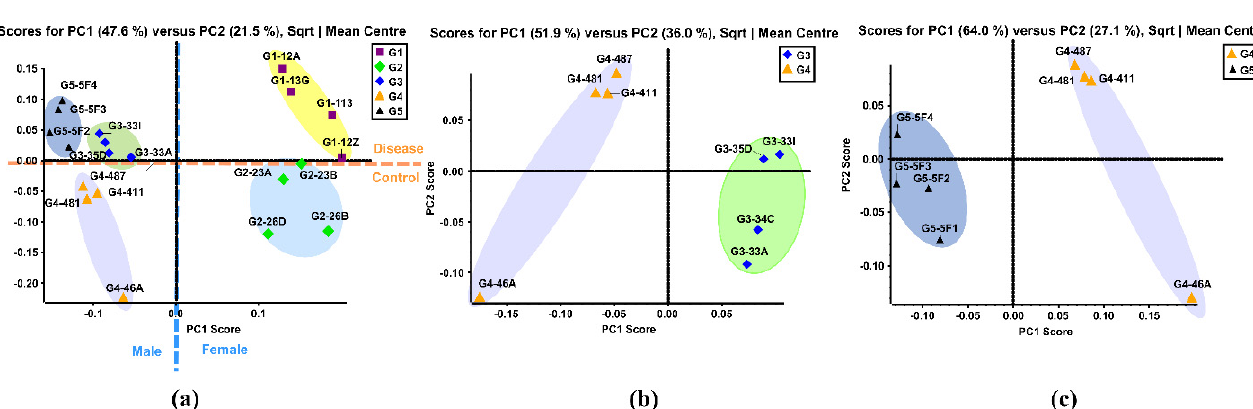
Figure 1. ( a ) Unsupervised PCA of the BBMs N -glycans from five sample groups. Symbols with same color and shape were the replicates from same sample group. ( b ) Unsupervised PCA of the BBM N -glycans from old male with proteinuria and hypertension (G3) and young male control (G4). ( c ) Unsupervised PCA of the BBM N -glycans from male control (G4) and obese and diabetic male (G5). G3 were MWF male rats (32–42 weeks), G4 were MWF male rats (7 weeks), and G5 were ZSF1 male rats (16 weeks).